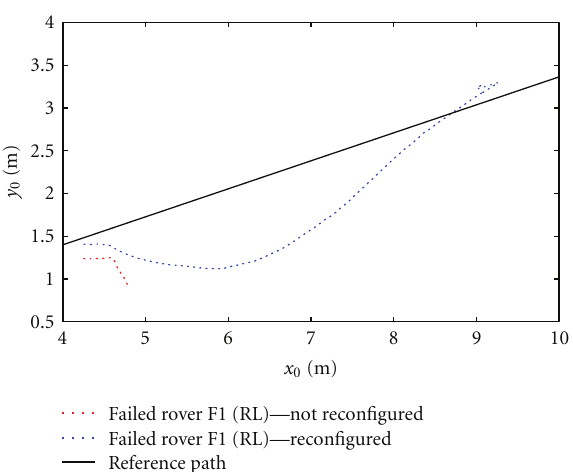
Figure 18: Fault-tolerant control performance for ExoMars rover under fault F1.